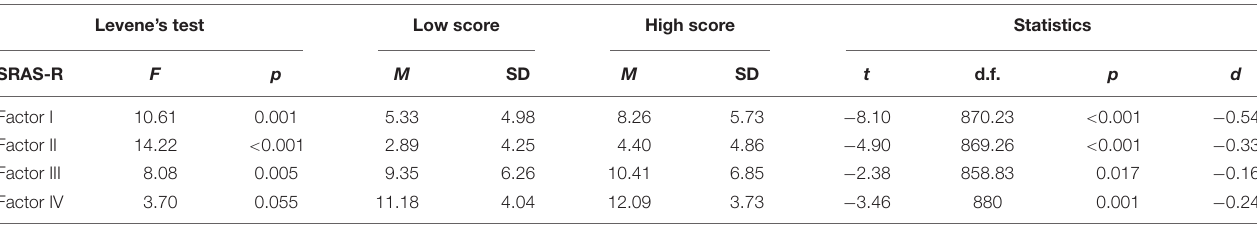
TABLE 3 | Differences in school refusal behavior in students with high and low scores on Verbal Aggression. Levene’s test